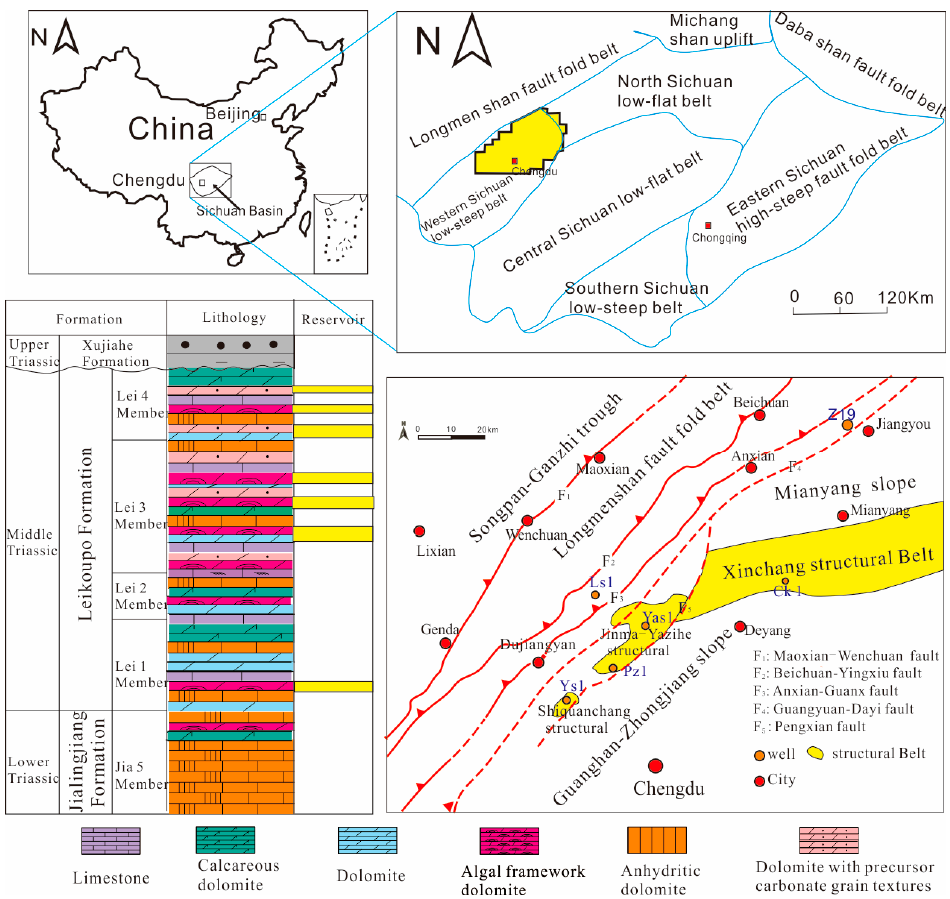
Figure 1. The location and tectonic characteristics of the study area, and the Middle Triassic stratigraphic column for the Western Sichuan